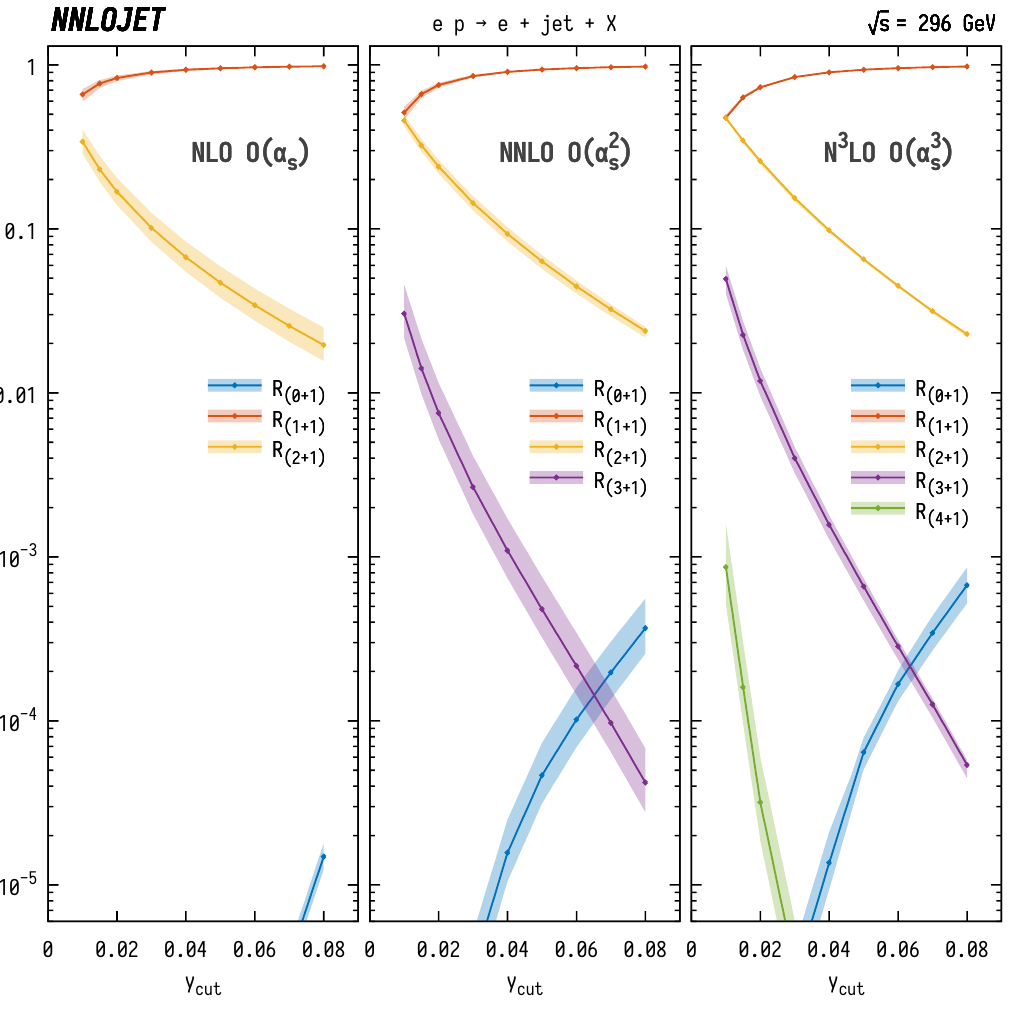
Figure 4 . Predictions up to N 3 LO in QCD for zero-, one-, two-, three-, and four-jet rates in the JADE algorithm for the kinematical cuts of eq.